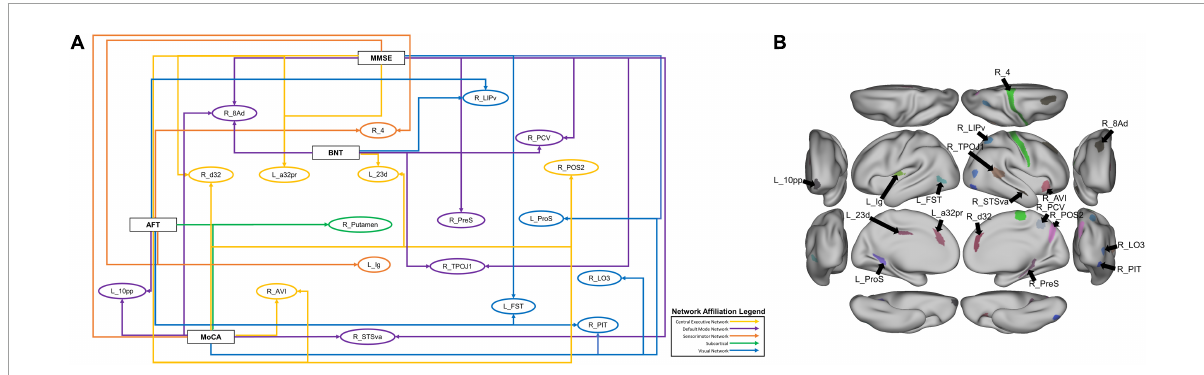
FIGURE4 (A) A schematic demonstrating the 19 parcels which were within the top 20 features of at least two models classifying neuropsychological test performance. Each arrow goes from a neuropsychological test label to a brain parcel. The color of each arrow indicates the network affiliation of the parcel with which it is associated. The parcels have been placed in rough anatomical space. (B) The same parcels, with the exception of the subcortical right Putamen represented on a brain for anatomical